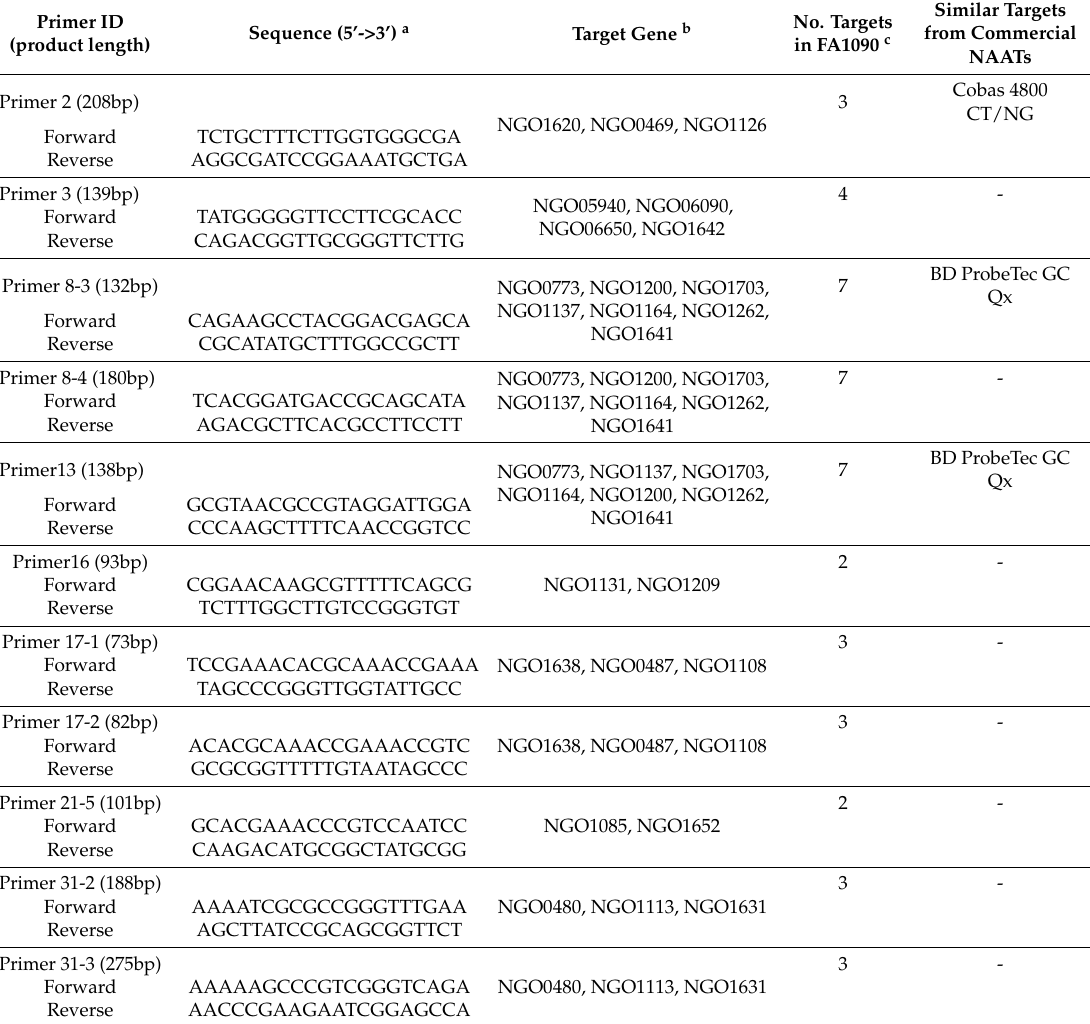
Table 1. Primer sequences used in this study for detection of N. gonorrhoeae , their respective targets and copy numbers present in the N. gonorrhoeae genome.